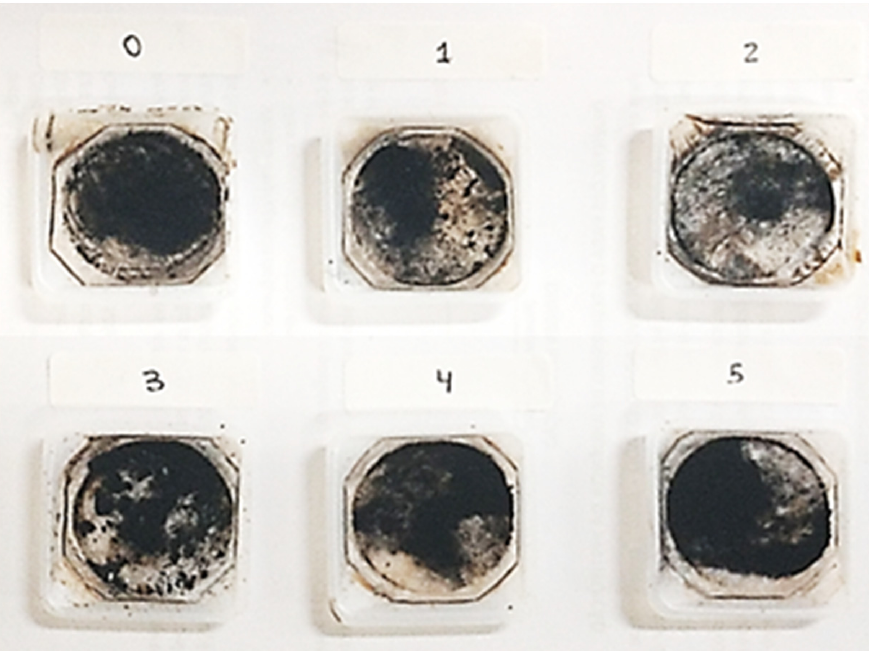
Figure 3. Samples of iron oxide NPs after drying. Pure Fe 3 O 4 NP sample (NP0), functionalized with progressive amounts of Pluronic F-127 (NP1, NP2, NP3, NP4, and NP5). For more information, see Table